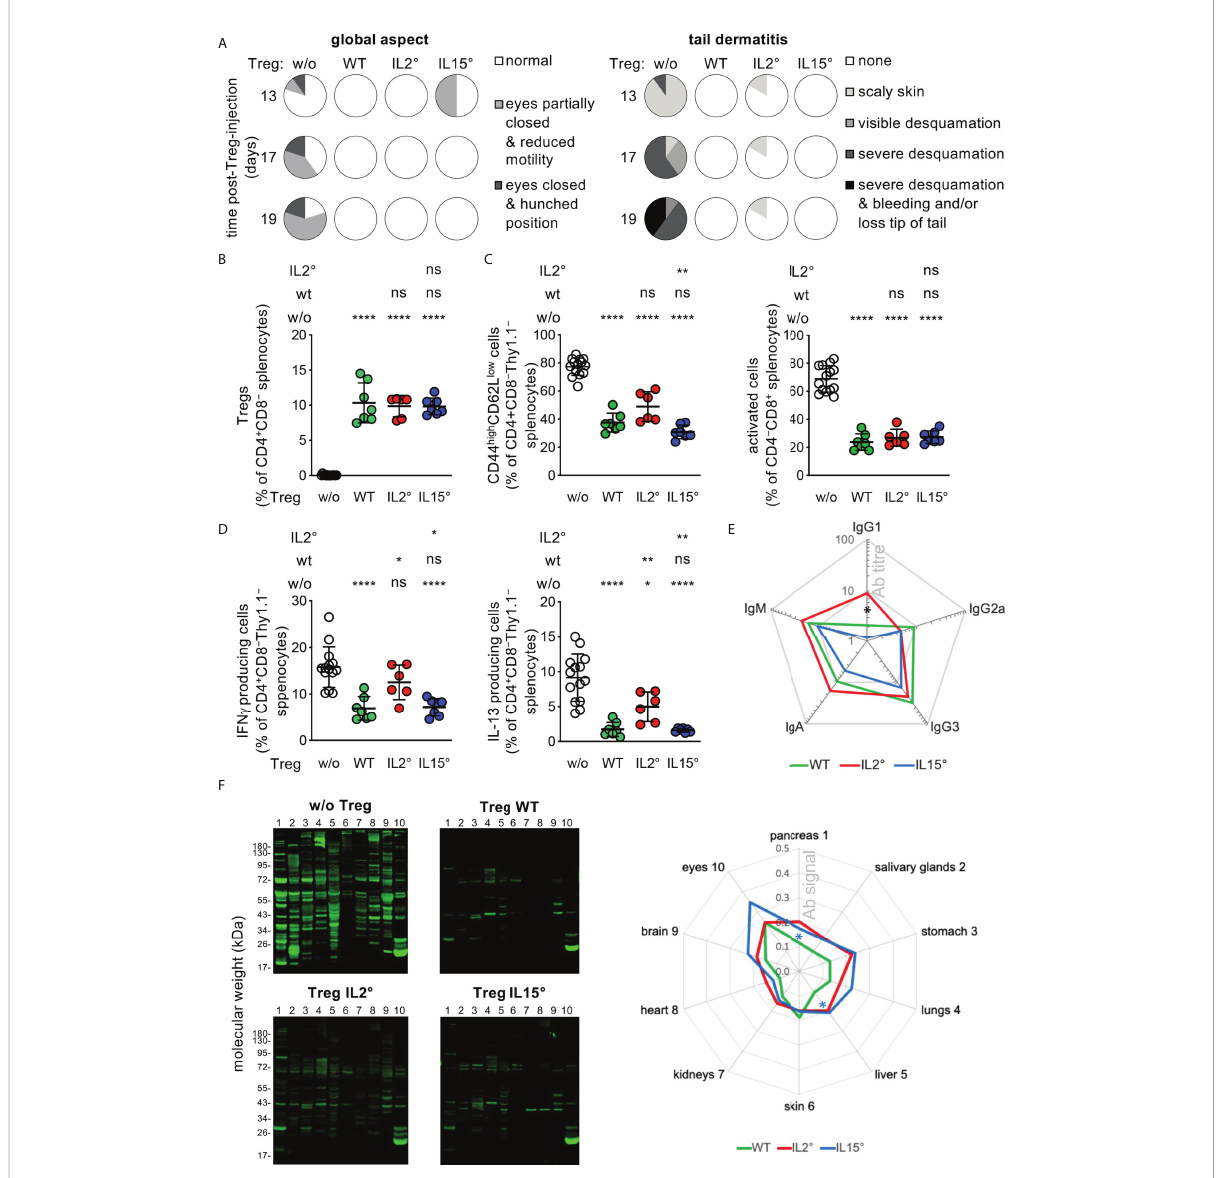
FIGURE 5 Treg developing in Il2° vs. Il15° mice have distinct in vivo functions. Newborn Foxp3 sf mice were i.v. injected with electronically sorted newly developed thymic Treg from three-week-old Rag2-Gfp Foxp3-Thy1 a wt, Il2° , or Il15° mice, or sham PBS-treated, and analysed three weeks later. (A) Eye pathology, reduced motility, hunched posture, and tail-skin-pathology in control scurfy mice, and its prevention upon neonatal injection of thymic Treg from wt, Il2° and Il15° mice. See Figure S8 for representative pictures of mice, tail close-ups, and lymphadeno- and spleno- megaly. (B) Reconstitution of Treg levels in the spleen of Foxp3 sf mice upon injection of wt, Il2° , or Il15° Treg. (C) Proportions of activated ( i.e. CD44 high CD62L low ) CD4 (left) or CD8 (right) Tconv in spleens. (D) IFN- g (left) and IL-13 (right) producing CD4 + Tconv in spleens (as determined by fl ow-cytometry). (E) Titres of serum-antibodies of indicated isotypes. “ Ab titre ” is expressed as mean % of that found in sham-treated Foxp3 sf mice (IgG1, 73.1 ± 35.9; IgG2a, 2.4 ± 2.4; IgG3, 1.2 ± 0.4; IgG2b, 0.0 ± 0.0; IgA, 38.0 ± 6.9; IgM, 137.1 ± 40.6 pg/ml). Mice injected with Treg from wt, Il2° or Il15° mice had lower titres of all detected antibody-isotypes than sham-treated animals (p ≤ 0.01, Mann-Whitney test). (F) Autoantibodies in sera from indicated mice (as determined by incubating Western blots carrying total extracts from indicated Rag2° tissues with sera). Representative blots (left panels) and semi-quanti fi cation of total signals on indicated tissues (right panel, mean ratios Treg-injected/ sham-injected mice) are shown. Numbers on the left side correspond to the tissues indicated on the right side. Statistical signi fi cance concern differences between mice that had received IL2°vs. IL15 ° Treg (black asterisk in (E) and IL15 ° Treg vs. wt Treg (blue asterisks in (F) . Sham-treated Foxp3 sf mice, n=14, 8 independent experiments; Foxp3 sf mice injected with thymic Treg from wt mice, n=7, 3 experiments; from IL-2 ° mice, n=6, 3 experiments; from IL-15 ° mice, n=7, 4 experiments. ns, not signi fi cant; * p < 0.05; ** p < 0.01; **** p < 0.0001 (Mann-Whitney test). Dots indicate individual mice. Bars indicate mean values ±